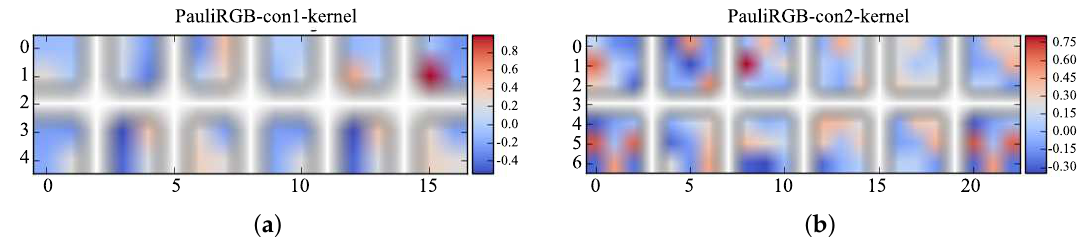
Figure 17. Visualization of the convolution kernel of the PauliRGB-CNN: ( a ) visualization of the convolution kernel in the first round of feature extraction; and ( b ) visualization of the convolution kernel in the second round of feature